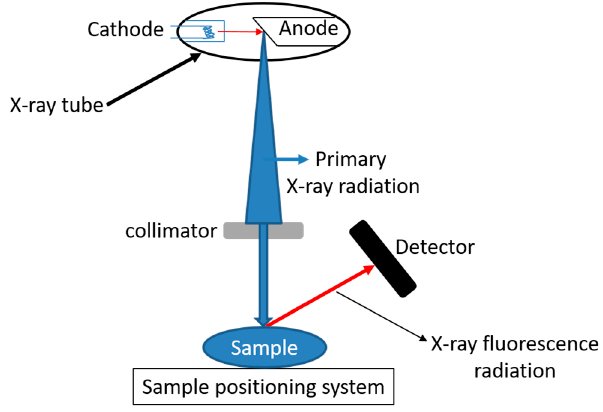
Figure 6. X-ray Fluorescence spectroscopy (XRF) principle.